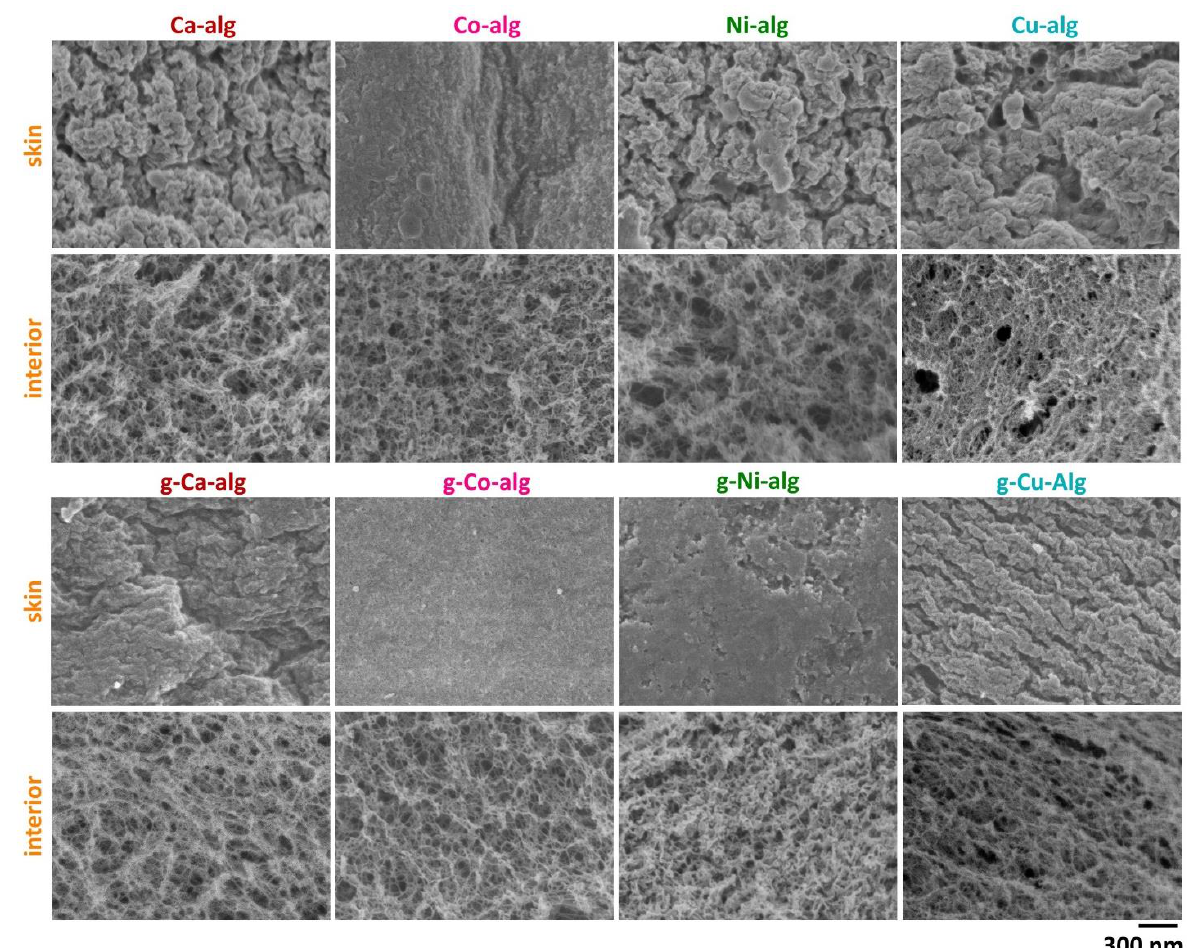
Figure 6. Representative SEM images of M-alginate and g-M-alginate aerogels, as indicated.